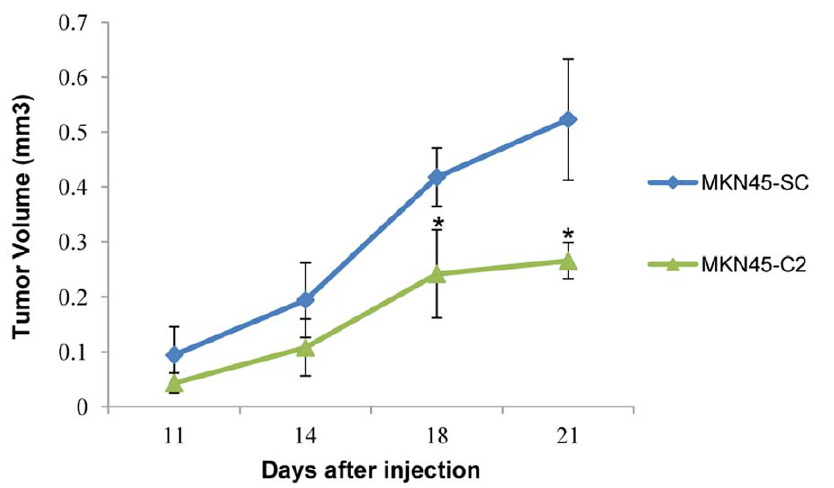
Figure 5. Study of the tumorigenicity of MKN45 gastric carcinoma cells invivo . Tumor growth curves. 1 6 10 5 cells were subcutaneously injected in mice at day 0. The curves show tumor growth until day 21, the day on which all mice were sacrificed.* P , 0.05, when compared to the MKN45-SC control cell line.